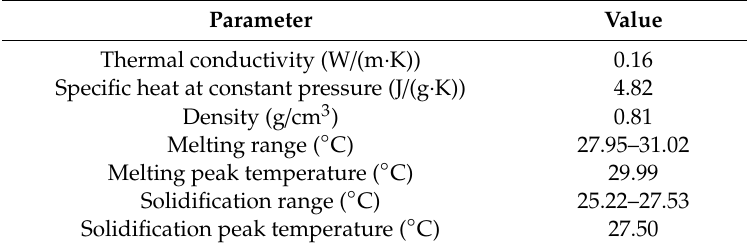
Table 3. Physical parameters of the 4.87% DE-95.13% CA (30 ◦ C).